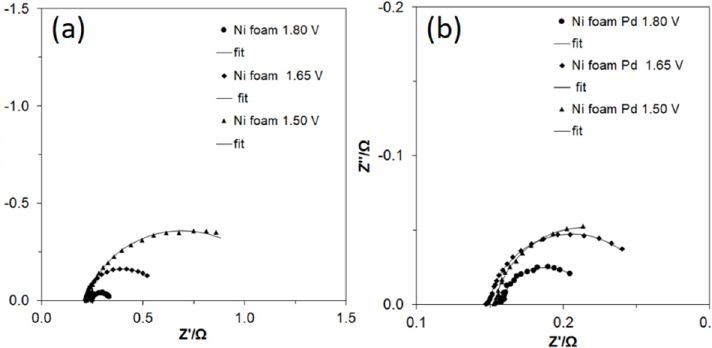
Table 3. a.c. impedance parameters (total, average values of charge-transfer resistance, R ct and double-layer capacitance, C dl parameters), derived for a single electrolyser cell (anode: Ni foam; cathode: unmodified and Pd-modified Ni foam) recorded in 8 M KOH solution, at the temperature Figure 6. Nyquist impedance plots for alkaline water electrolysis process (total impedance meas- of 45 °C. ured for a single-cell electrolyser unit), carried out for indicated cell voltages, on cathodes of un- modified ( a ) and palladium-activated nickel foam material ( b ), recorded in 8 M KOH at 45 °C.